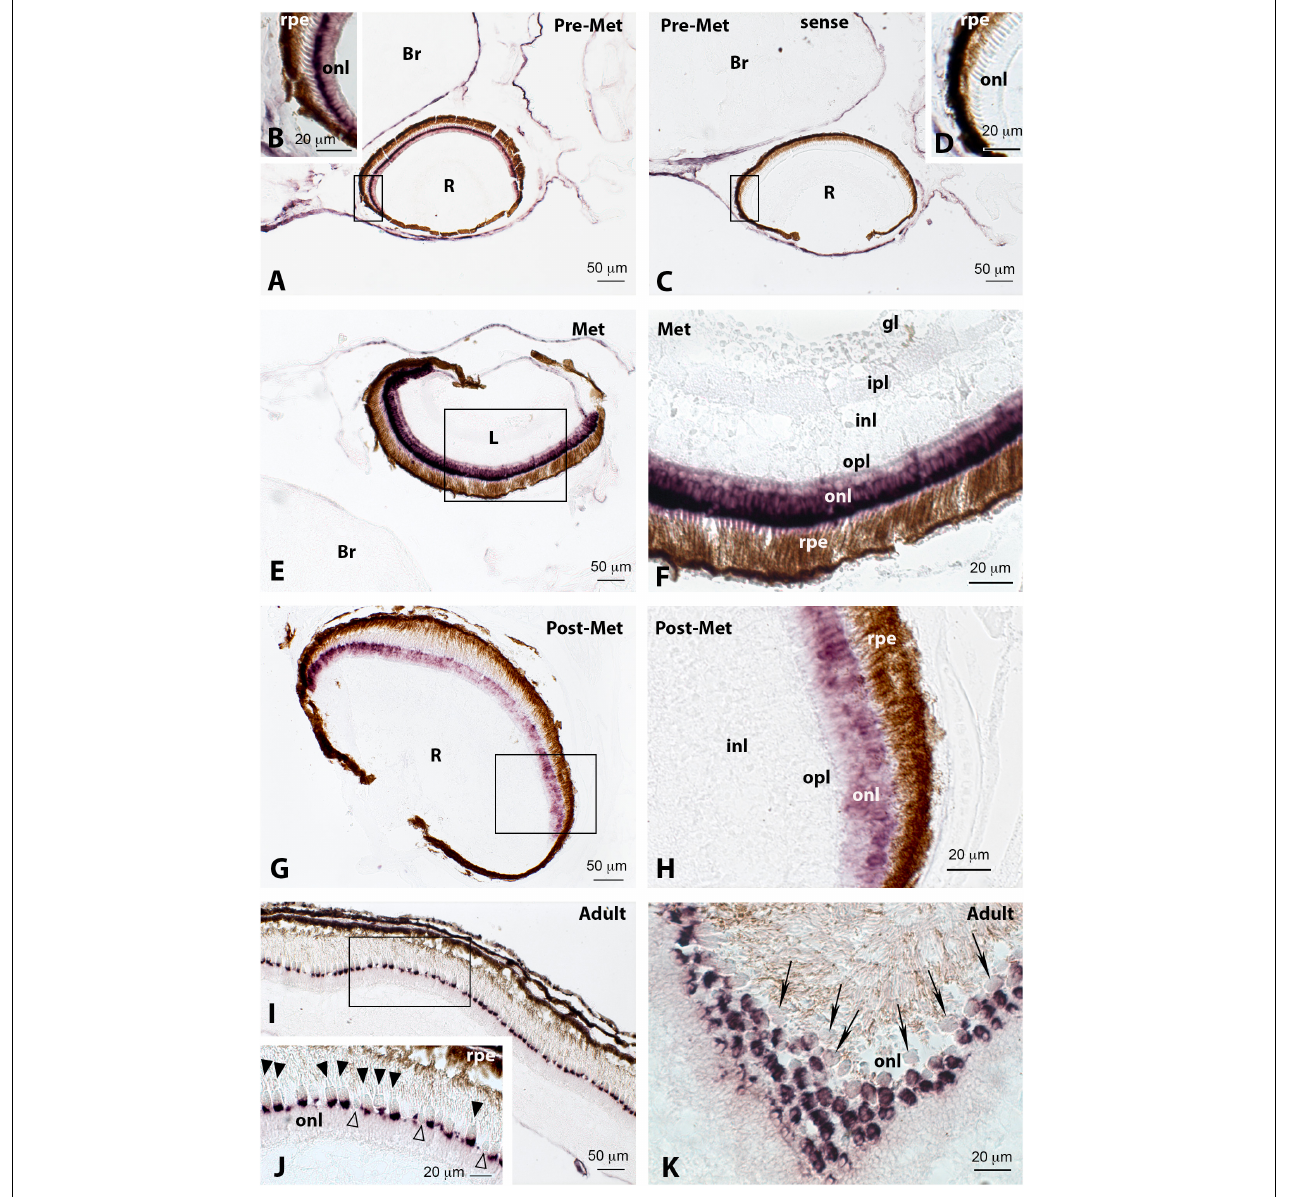
FIGURE 9 | Localisation of green cone opsin ( rh2.4 ) expression in the retina of pre-metamorphic (Pre-Met; A–D ), metamorphic (Met; E,F ), post-metamorphic (Post-Met; G,H ), and adult (I–K) Senegalese sole specimens revealed by in situ hybridisation. All the photomicrographs represent antisense sections, with the exception of panels (C,D) , which show sense control sections. Squares in panels (A,C,E,G,I) mark the areas magnified in photomicrographs (B,D,F,H,J) , respectively. Note the intense labelling in the retina of pre-metamorphic (A) and metamorphic (E,F) animals, compared to post-metamorphic (G,H) and adult (I–K) specimens. In the adult retina, rh2.4 expression appears evident in the basal region of the inner segments of double cones ( J , black arrowheads), with the single cones being devoid of labelling ( J , white arrowheads). Some double cones appear unlabelled, as seen in photomicrograph (K) (black arrows). For abbreviations, see the legend in Figure 2 . Scale bars represent 20 µ m in panels (B,D,F,H,J,K) ; and 50 µ m in panels (A,C,E,G,I)